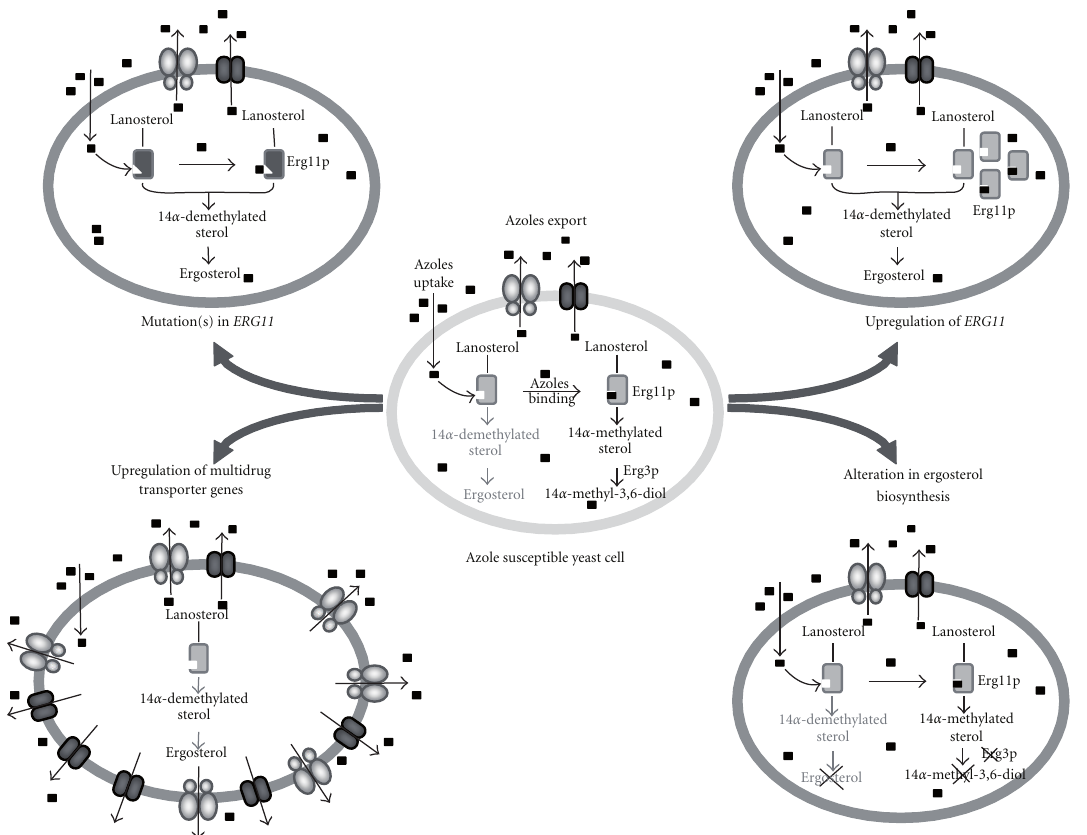
Figure 8: Mechanisms of resistance to azole compounds in C. albicans